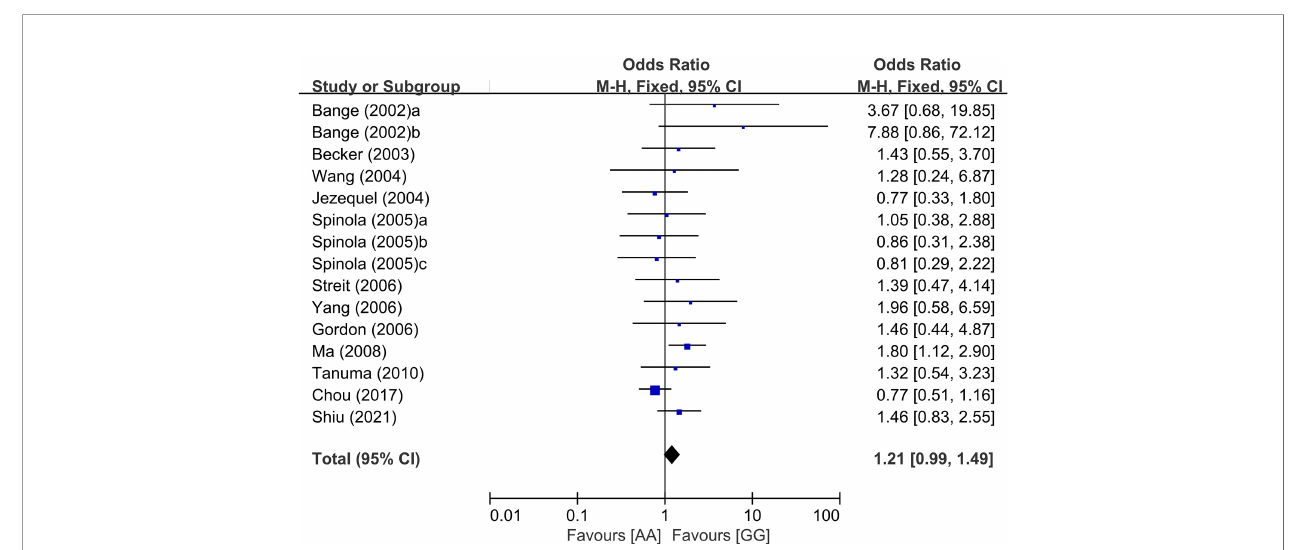
FIGURE 2 | Forest plot for lymph node in the homozygous model (AA vs.